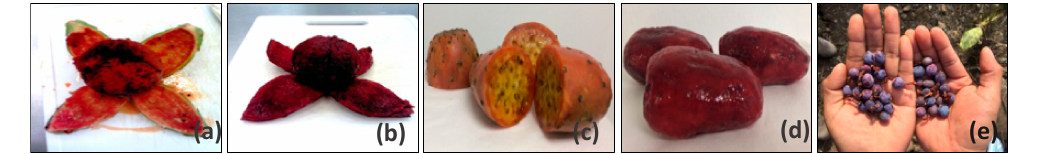
Figure 1. Cactus fruits ( a ) Stenocereus pruinosus yellow fruit (SY), ( b ) Stenocereus pruinosus red fruit (SR), ( c ) Opuntia ficus-indica yellow fruit (OPY), ( d ) Opuntia ficus-indica red fruit (OPR), ( e ) Myrtillocactusgeomettizans fruit